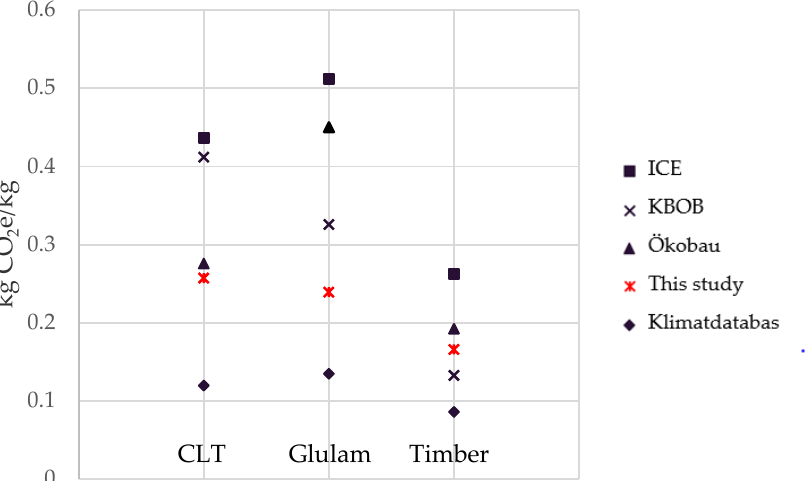
Figure 11. A1–A3 GWP values per kg of wood product (without biogenic CO 2 ) from the current Figure 11. A1 – A3 GWP values per kg of wood product (without biogenic CO 2 ) from the current study and as reported in publicly available databases for construction study and as reported in publicly available databases for construction products.